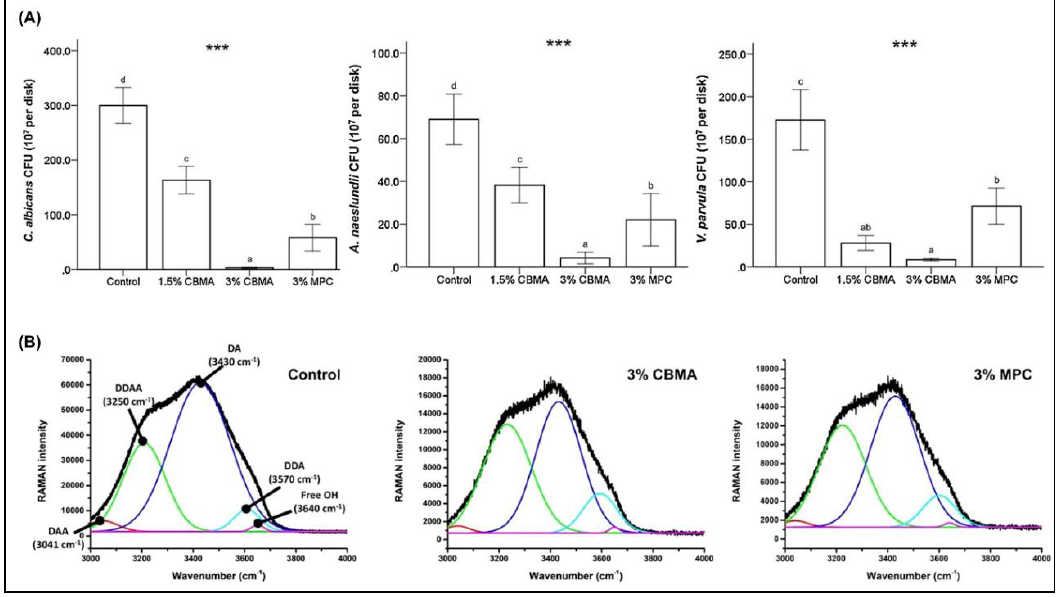
Figure 10. ( A ) Resistance to adherence against fungi and bacteria with addition of CBMA, showing improved performance compared to both the control group and MPC at 3 wt.%. ( B ) Collective band Raman spectroscopy observed for 3% CBMA and 3% MPC. MPC—2-methacryloyloxyethyl phosphorylcholine, CBMA—carboxybetaine methacrylate. The difference in the lower case letters indicate a significant difference between the groups. *** p < 0.001. Reproduced with permission from Jie et al. [89]; published by Elsevier, 2020.